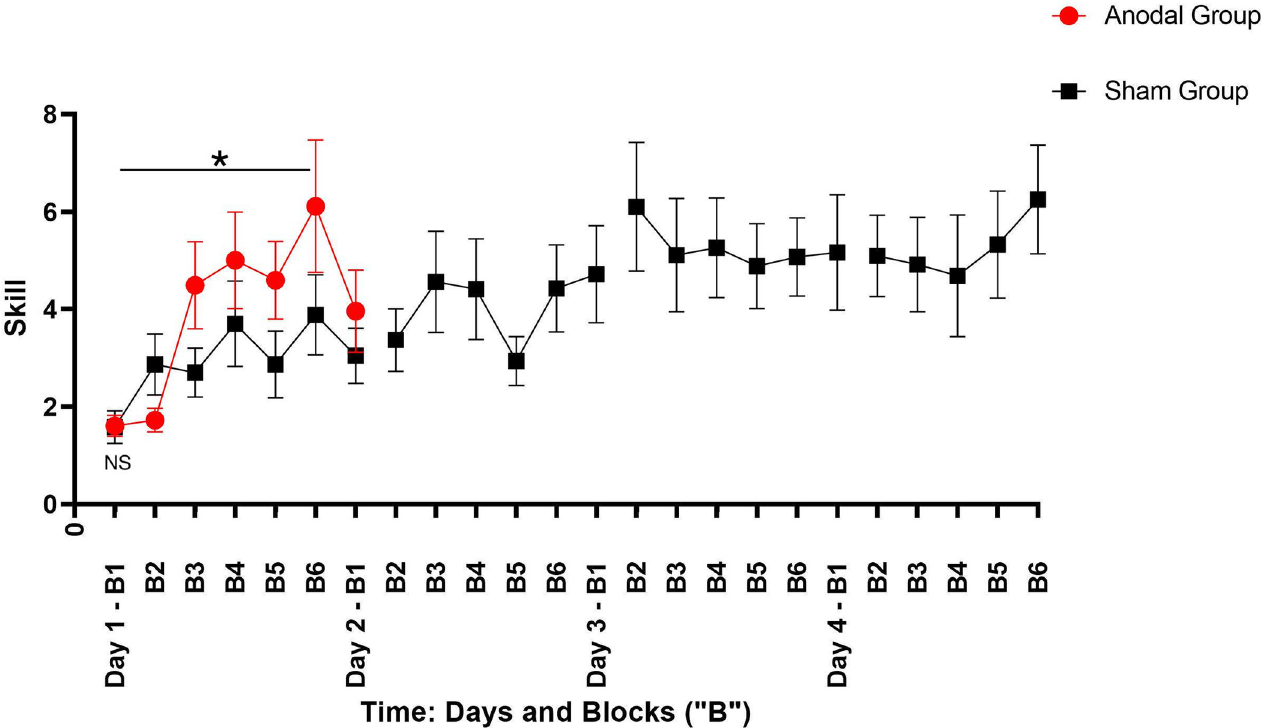
Fig 3. Performance across days of practice. Mean skill performance (y-axis) for each block of practice across days (x-axis). Bars represent standard error. Red circles represent data associated with performance of the anodal tDCS group (Anodal Group), and black squares represent data associated with performance of the sham tDCS group (Sham Group). On day 1 block 1, there is no significant difference (NS) in performance between the Anodal and Sham Groups (t = 0.234, p = 0.816). On day 1 across both groups, there is a significant improvement in performance across blocks of practice (F(1,249) = 49.21, p < 0.001). The Anodal Group also had a significantly greater increase in performance across blocks of practice as compared to the Sham Group (F(1,249) = 5.90, p = 0.015), indicated by the star ( �